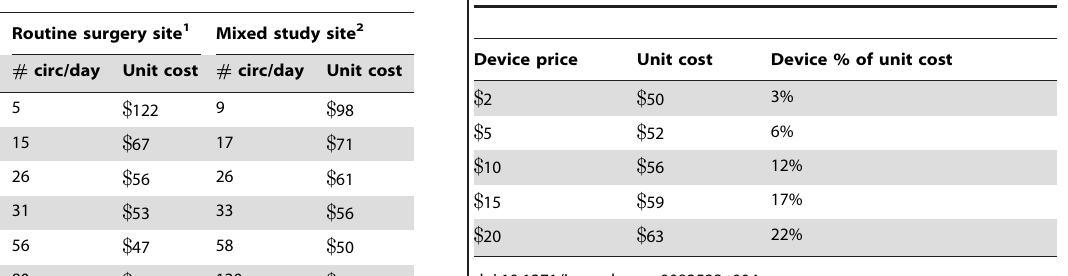
Table 3. Effect of site capacity utilization on unit cost at routine surgery site and mixed study site.